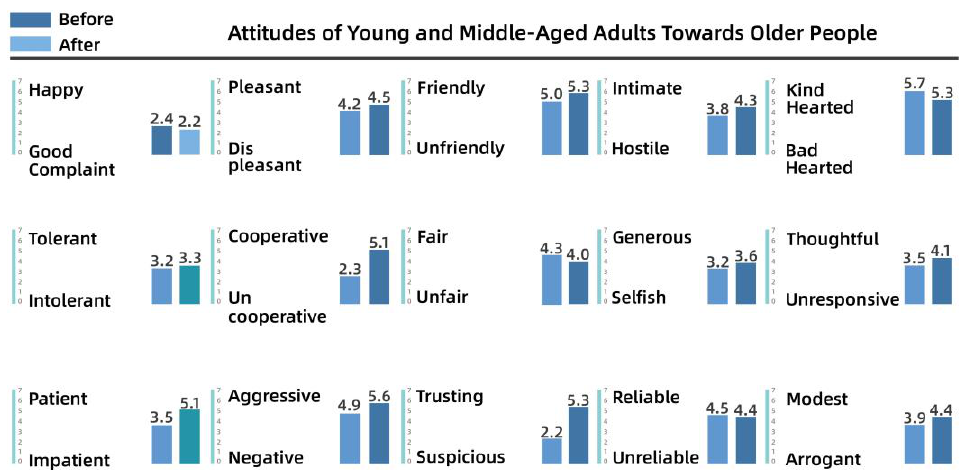
Figure 10. Attitudes of young and middle-aged adults toward children.